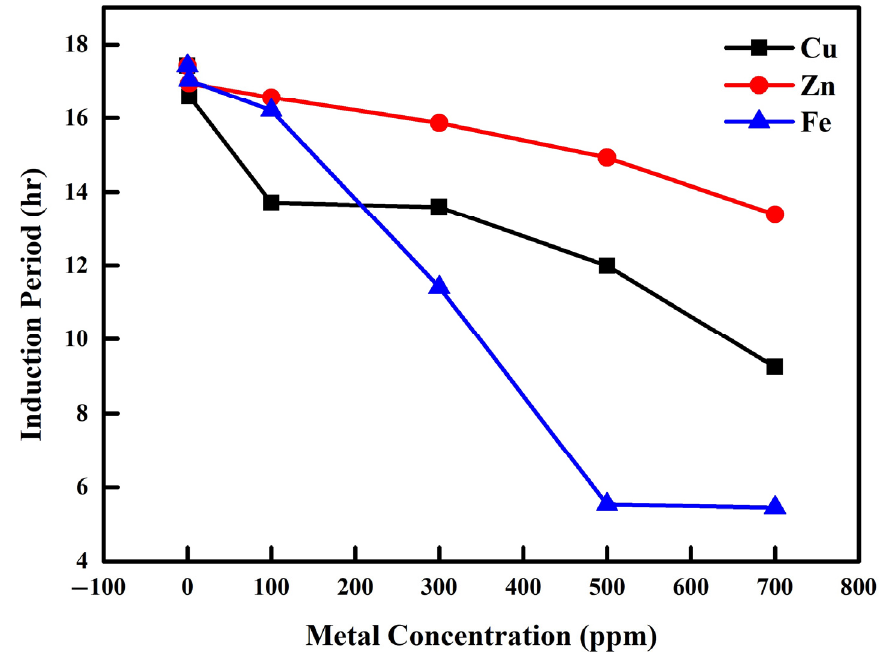
Figure 6. Oxidation stability in palm biodiesel before and after exposure to metals.